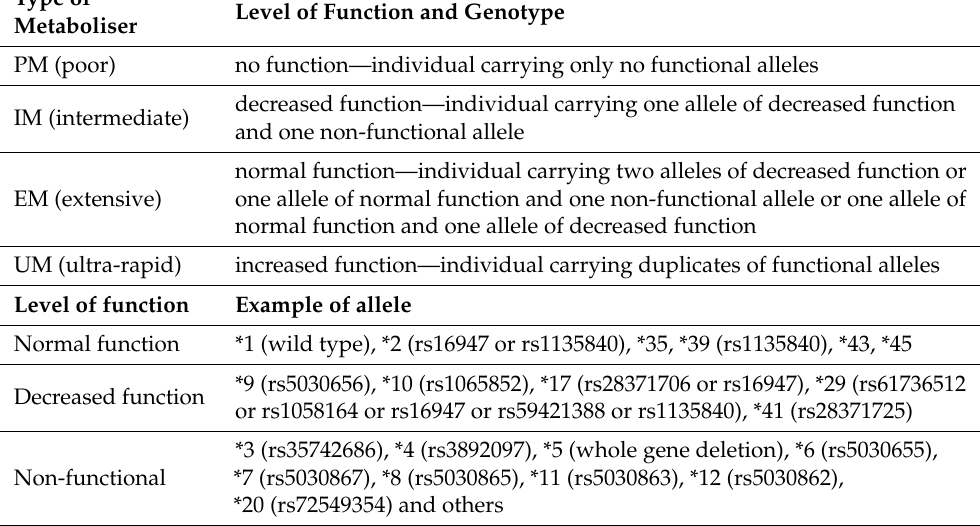
Table 1. Alleles of CYP2D6 gene and their impact of functionality: [33–35]. Type of Metaboliser